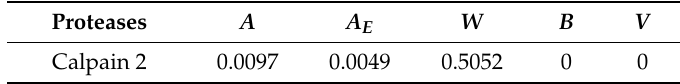
Table 9. The values of parameters describing the predicted e ffi ciency of release of bioactive immunomodulating fragment from Halophila stipulacea -RubisCO by proteases.